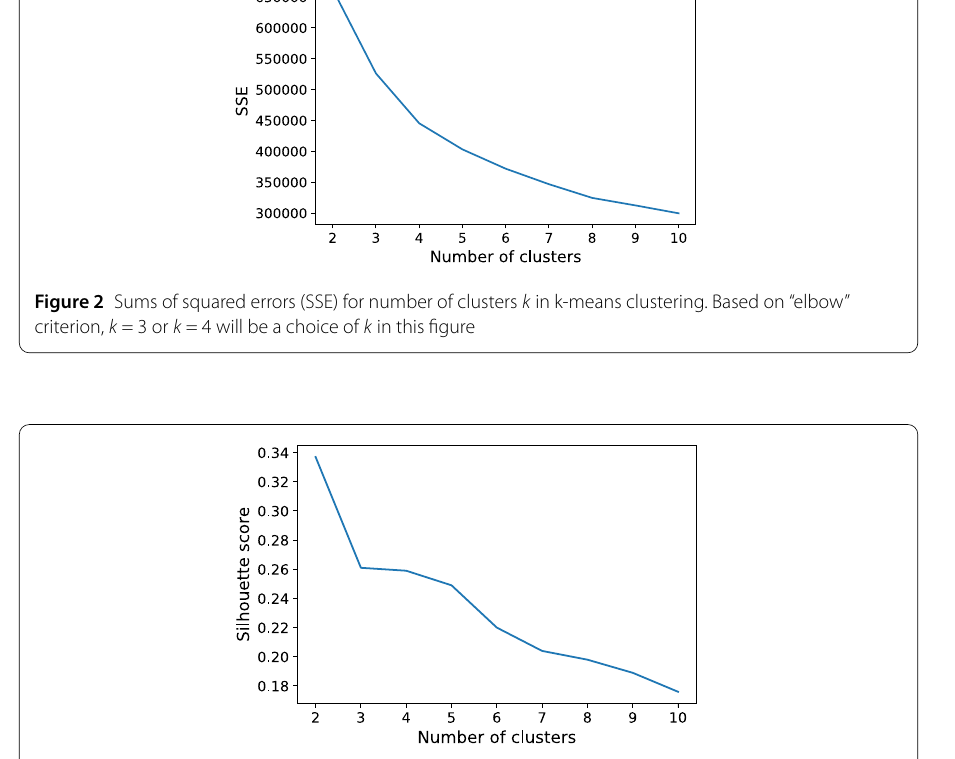
Figure 3 Silhouette score for number of clusters k in k-means clustering. Based on “elbow” criterion, k = 2 will be a choice of k in this